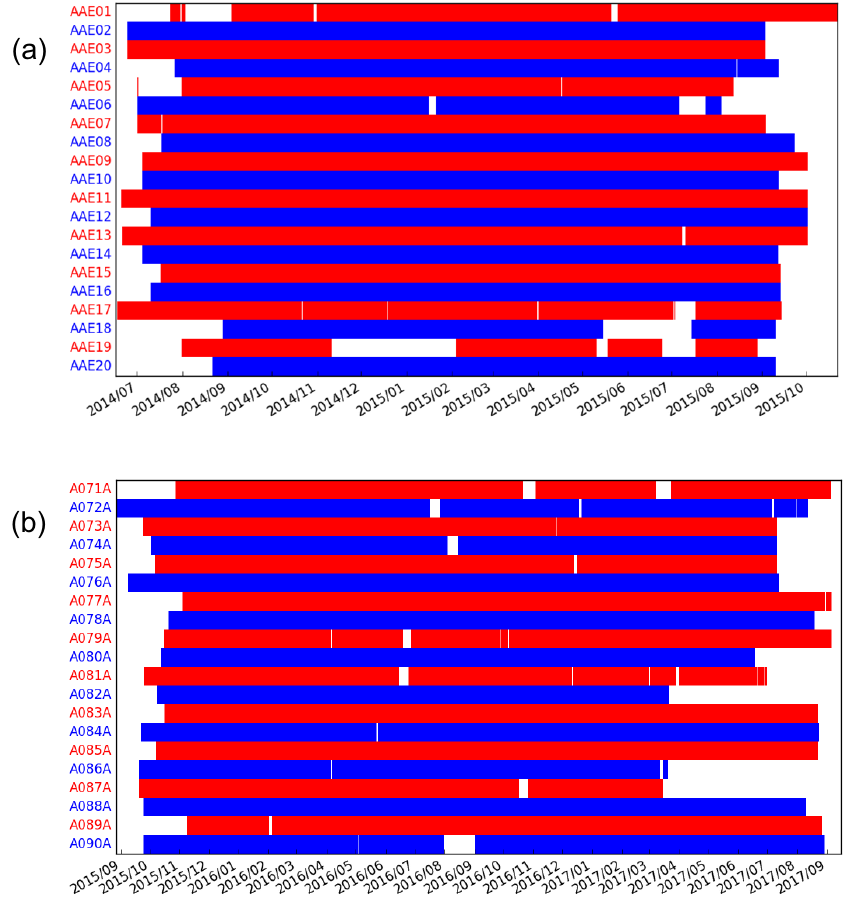
Figure 6. Data completeness of the MOBNET stations in the AlpArray projects: (a) in the AlpArray-EASI complementary field measure- ments and (b) in the ongoing AlpArray experiment.